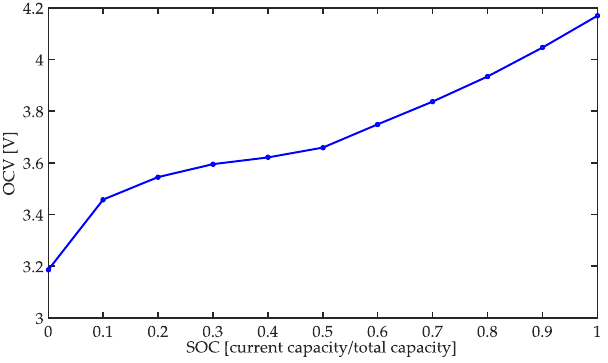
Figure 7. Relation between OCV and SOC.